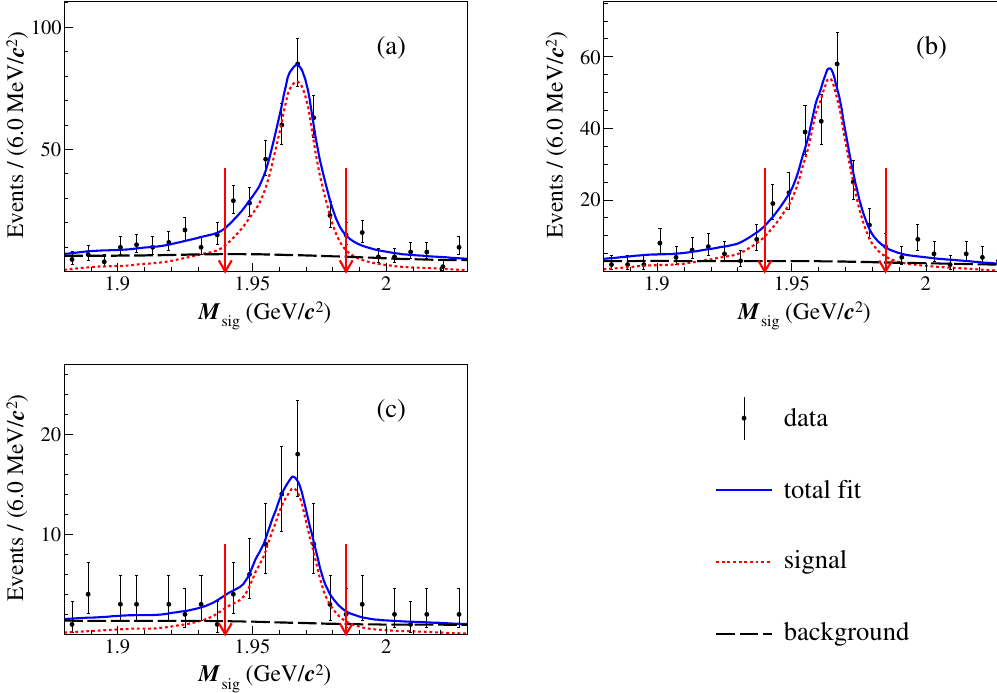
√ s = (a) 4.178 GeV, (b) 4.189–